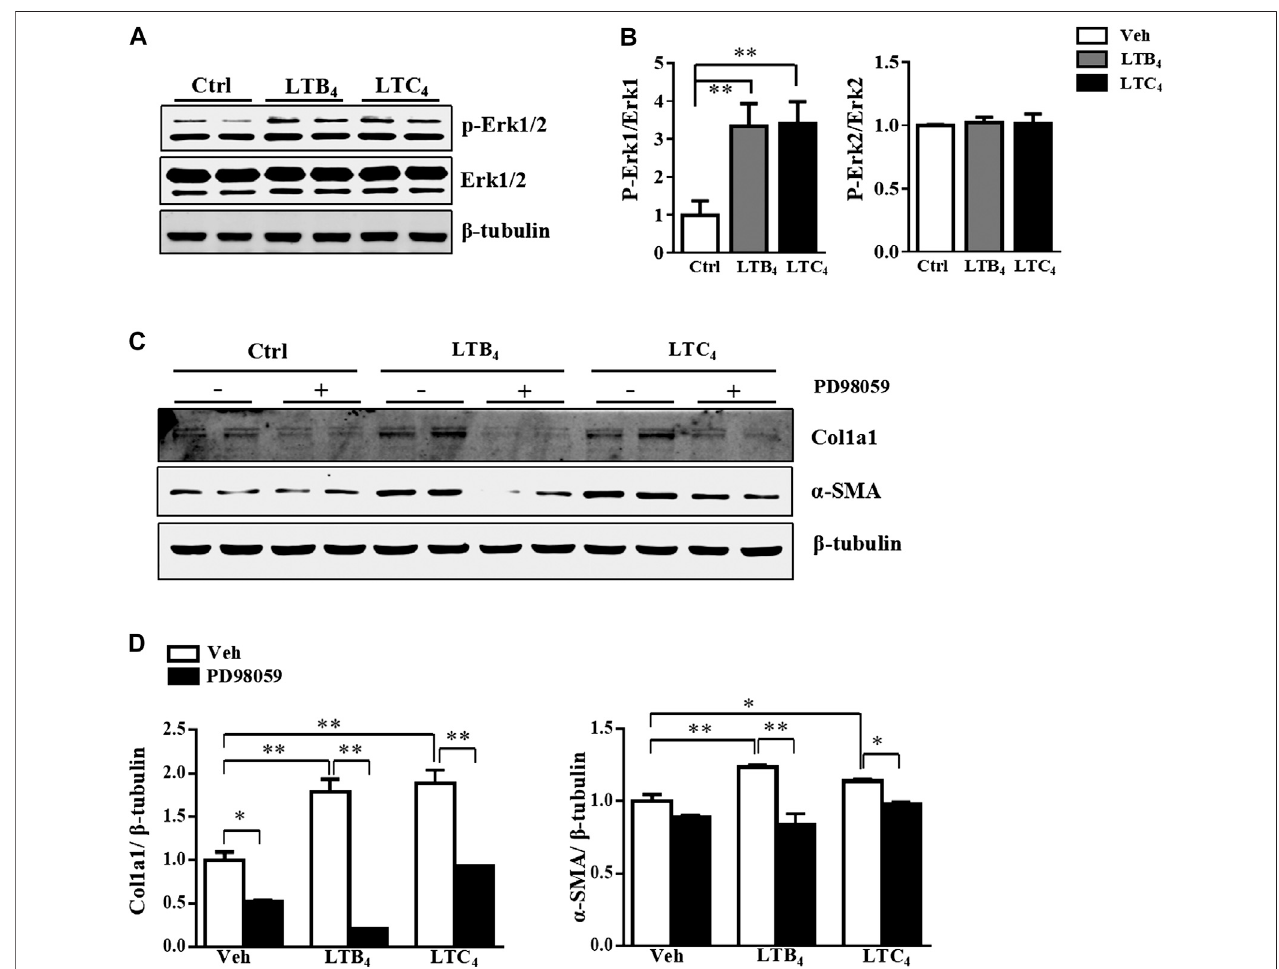
FIGURE2| LTB 4 andLTC 4 promoteHSC activationviaERK signaling pathway. (A,B) Theprotein levelsofp-ERK, t-ERKand β -tubulin inHSC aftertreatmentwith LTB 4 , LTC 4 or TGF- β 1 for 30 min (C,D) Western blot analysis of protein levels of α -SMA and Col1a1 in primary HSC isolated from 5-LO − / − mice and pre-treated with PD98059 before administration of